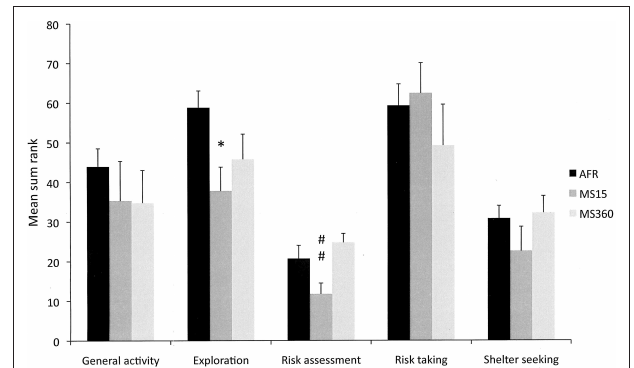
Figure 4 | The trend analysis in AFr, MS15 and MS360 dams (n = 6/group). In the trend analysis, the individual rank values for the parameters included in the functional categories general activity (TOTAL ACTIVITY, FRQ TOTCORR and CENTER, and DUR/FRQ TOTCORR), exploratory activity (DUR TOTCORR, CENTER and HUDLE, REARING, and number of PHOTOCELL COUNTS in the hole board), risk assessment (SAP to CENTER, and DUR/FRQ SLOPE and BRIDGE ENTRANCE), risk-taking behavior (FRQ BRIDGE and CENTRAL CIRCLE, DUR BRIDGE and CENTRAL CIRCLE, and DUR/FRQ BRIDGE and CENTRAL CIRCLE) and shelter-seeking behavior (FRQ, DUR, and DUR/FRQ DCR) are summed. * p < 0.05 compared to AFR dams; ## p < 0.01 compared to MS360 dams (Kruskal–Wallis, Mann–Whitney U